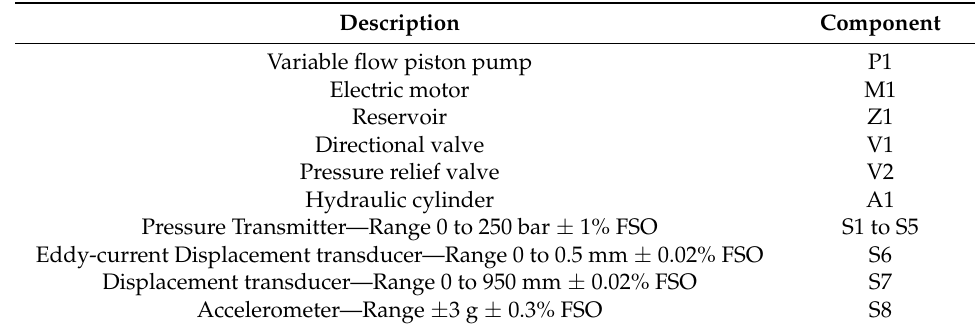
Figure 16. Hydraulic circuit and instrumentation schema. Table 4. Identification of the experimental set-up components.